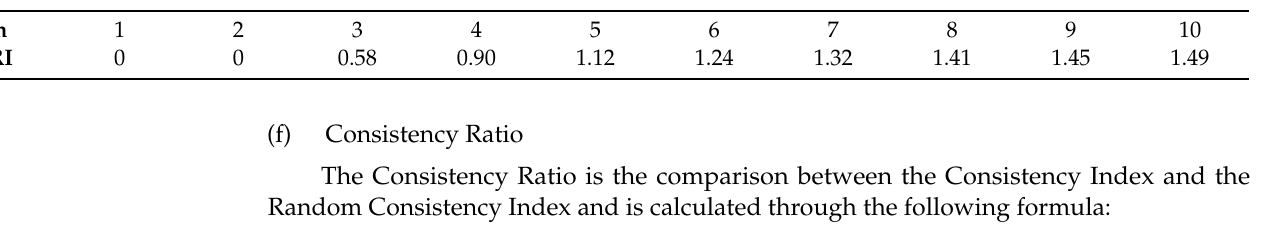
Table 6. Random Consistency Index (RI)